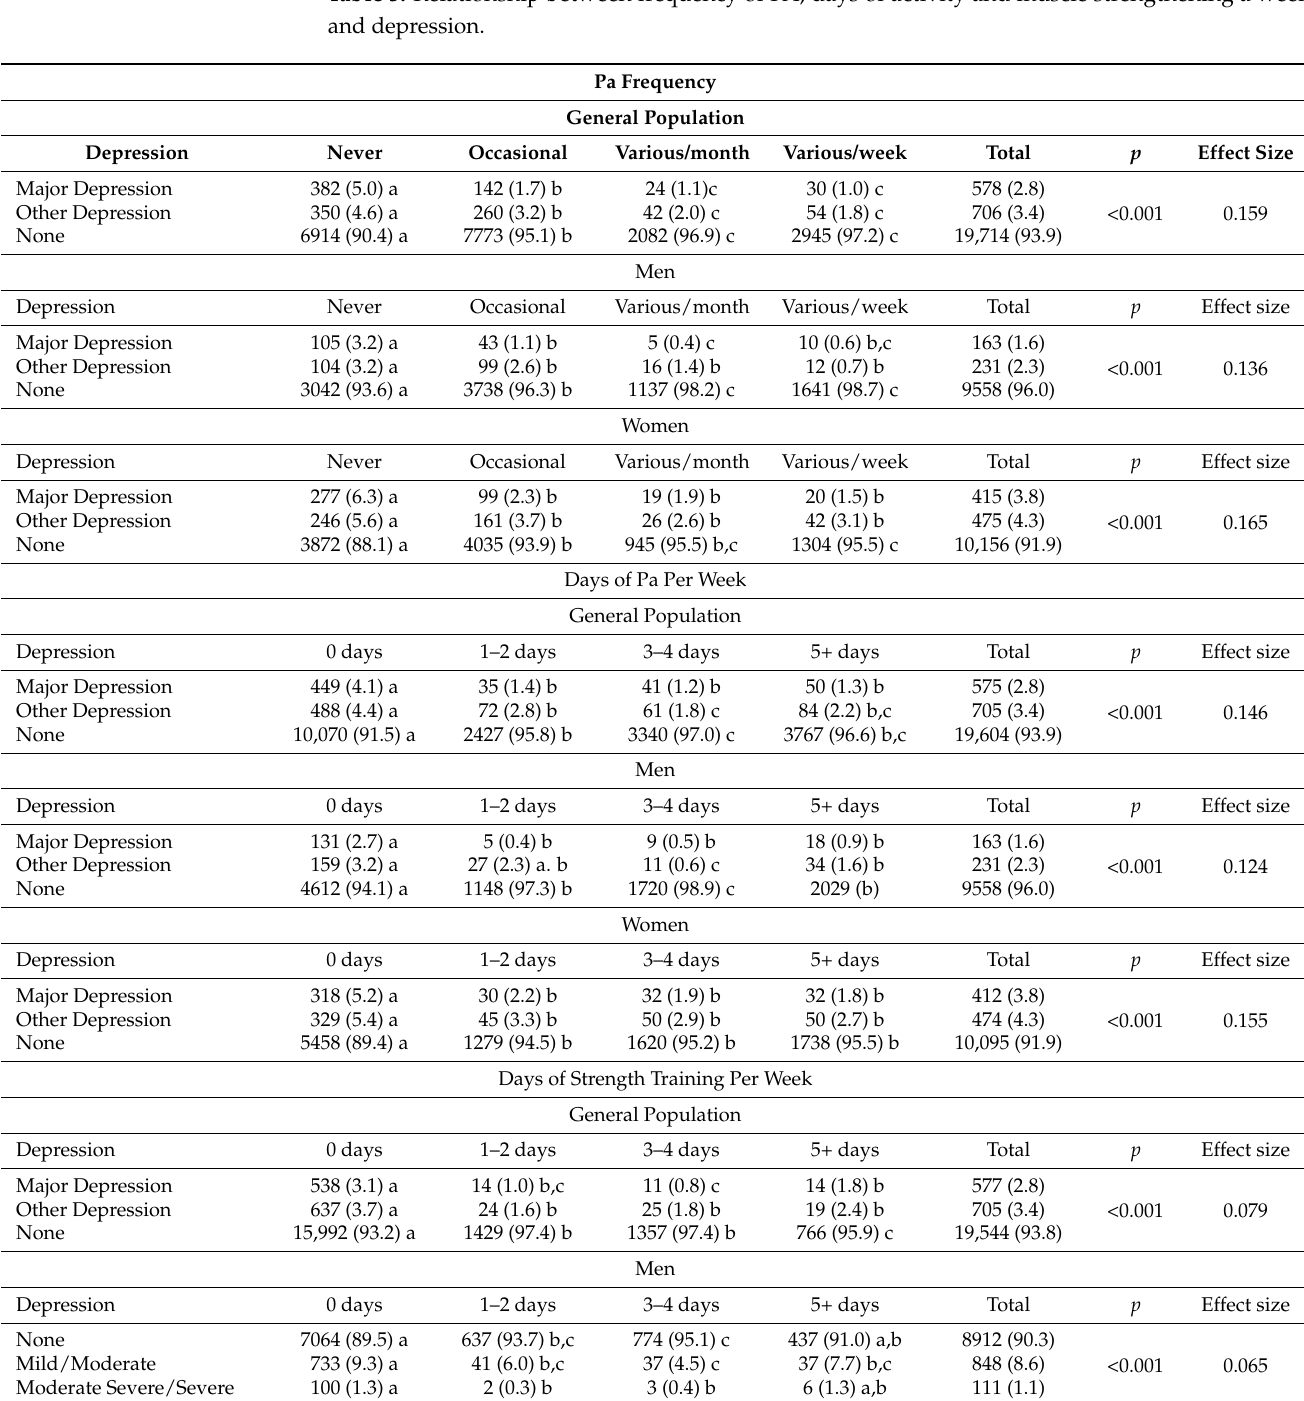
Table 4 shows the relationships found between depressive symptoms and frequency of PA, days per week of PA and strength training, in different age groups. As well as the differences in proportions that were found between the different PA groups. Except in the youngest age group (18–34 years), significant dependency relationships were found between presenting any depressive symptom and the PA variables, with p < 0.001 (for frequency of PA and days of PA per week) and p < 0.05 (for days of strength training, except in the 35–49 age group, with p < 0.001). Table 3. Relationship between frequency of PA, days of activity and muscle strengthening a week and depression. Pa Frequency General